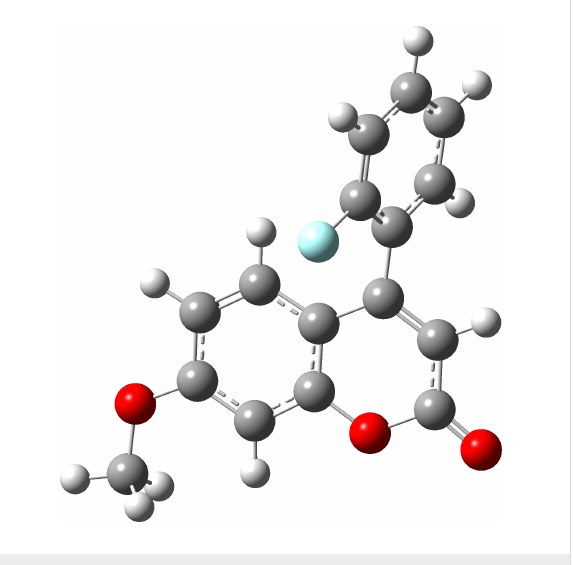
Figure 5: DFT-optimized structure for coumarin ( 6